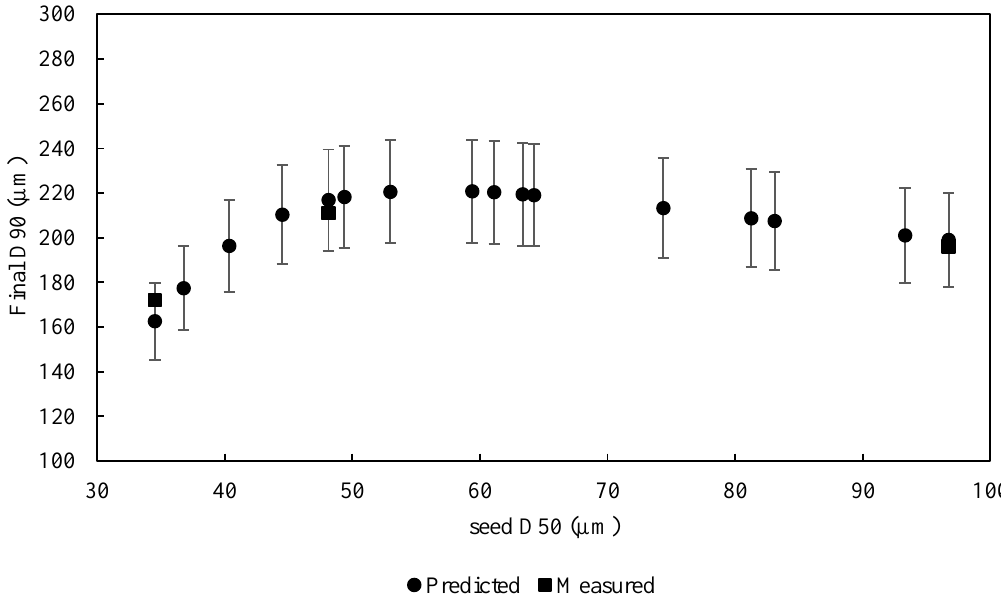
Figure 3. Predicted impact of seed D50 (μm) on final D90 (μm) shown in circles, as compared with experimentally validated points shown in squares (three points). Model predictions have good agreement with experimental data.